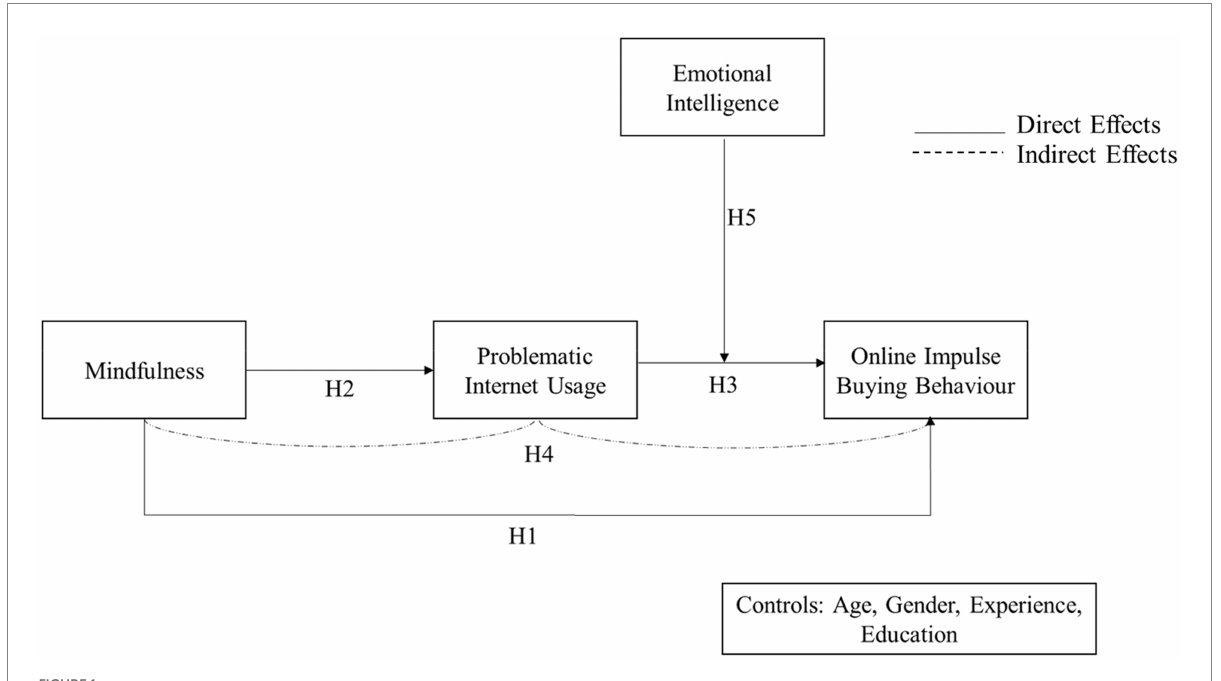
FIGURE 1 Conceptual Framework of the